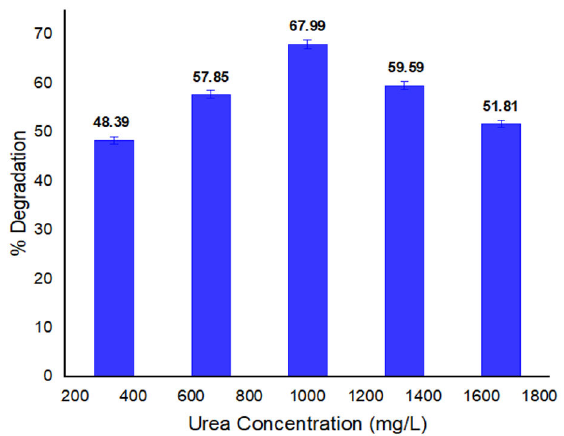
Figure 7. Urea concentration effect on methyl red %